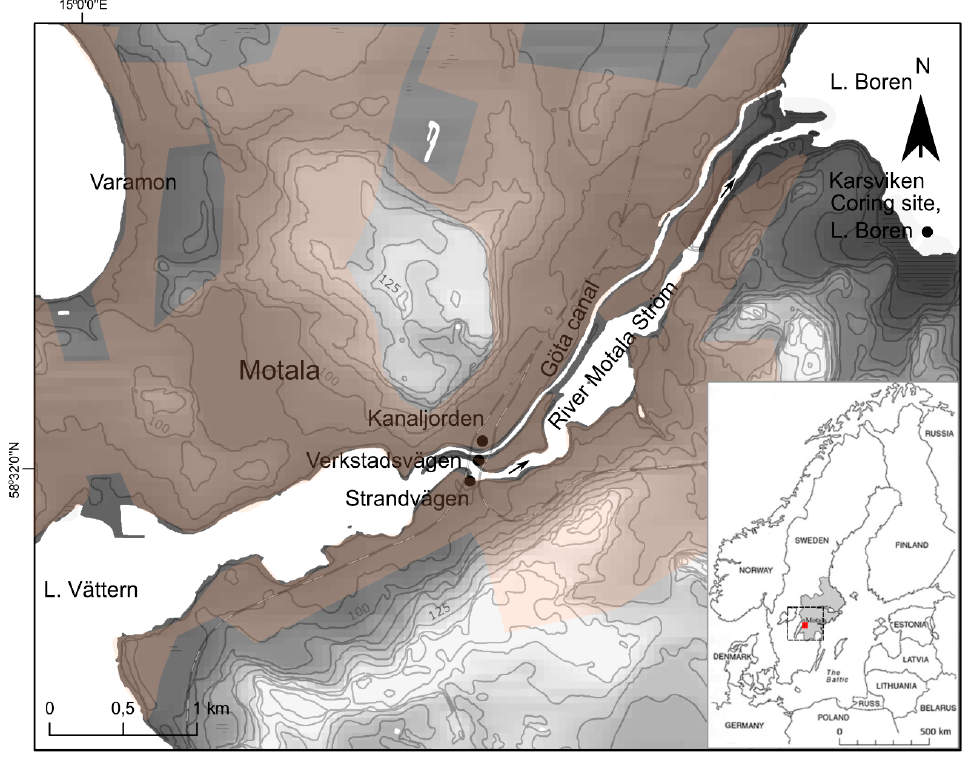
Figure 1. Elevation map with present-day River Motala Ström, the Strandvägen and Kanaljorden Mesolithic sites, and the coring site in Lake Boren. Lake Vättern had, during the early 20th century, a mean water level of 88.5 m a.s.l., and Lake Boren ca. 72 m a.s.l. Urban areas are marked in reddish color. Encapsulated: The town of Motala in east-central Sweden in red and the province of Östergötland highlighted in grey. The dashed box indicates Figure 2.